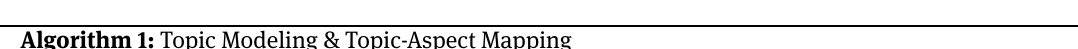
Algorithm 1: Topic Modeling & Topic-Aspect